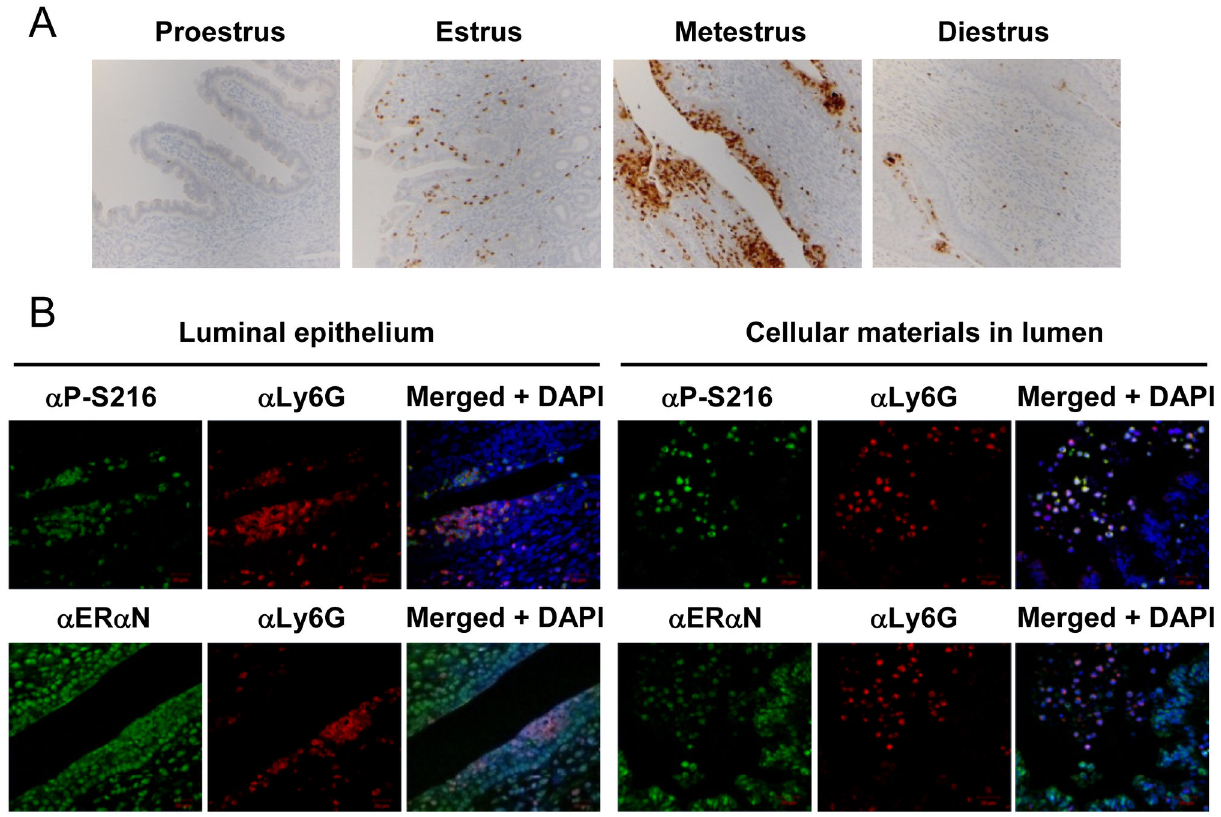
Figure 3. Phosphorylated ERα-expressing neutrophils during the estrous cycles. (A) Mouse uterine sections (at the proestrus, estrus, metestrus or diestrus stage) were stained by an anti-Ly6G antibody (αLy6G). (B) Sections were prepared from the mouse uterus at the metestrus stage and subjected to fluorescence double staining with αLy6G and either αP-S216 or αERαN. Immunoreactions were visualized as described in the legend of Figure 2. DAPI stains